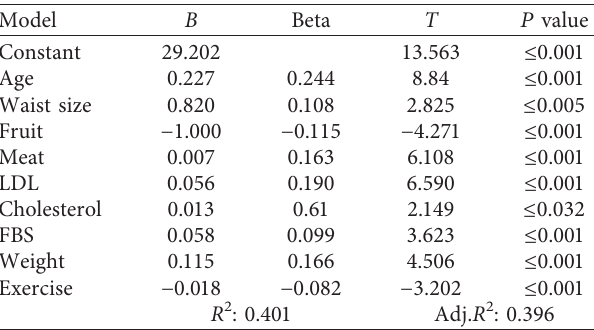
Table 6: The multiple linear regression model predicting DBP changes based on